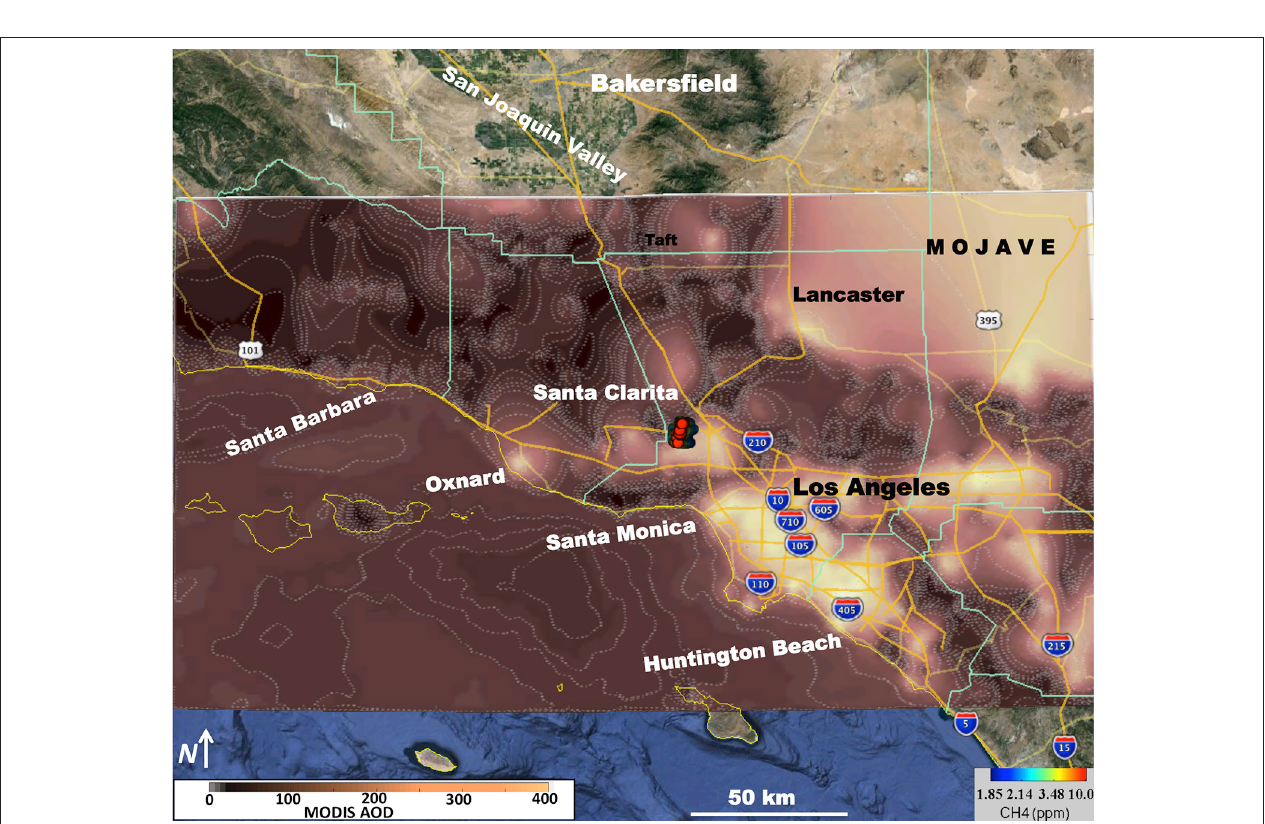
FIGURE 6 | Aerosol Optical Depth (AOD) from MODIS for 2055 UTM, 13 November 2015, for southern California. Also shown is the Aliso Canyon plume methane (CH 4 ). Data keys on